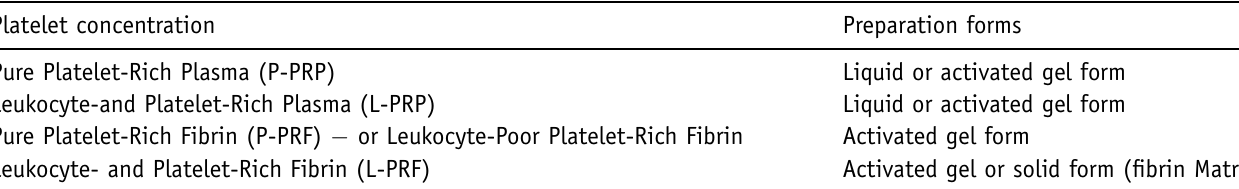
Table I. Classi fi cation and preparation forms of various PCs. Platelet concentration Preparation forms Pure Platelet-Rich Plasma (P-PRP)